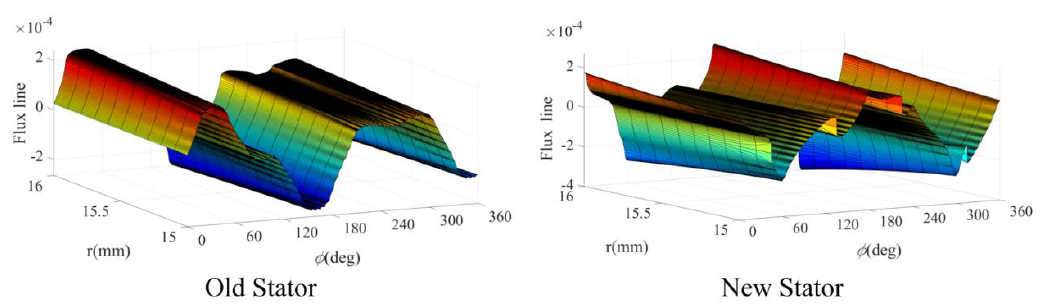
Figure 7. Distribution of stator magnetic field flux lines. Figure 8. Distribution of air gap flux lines of motor.